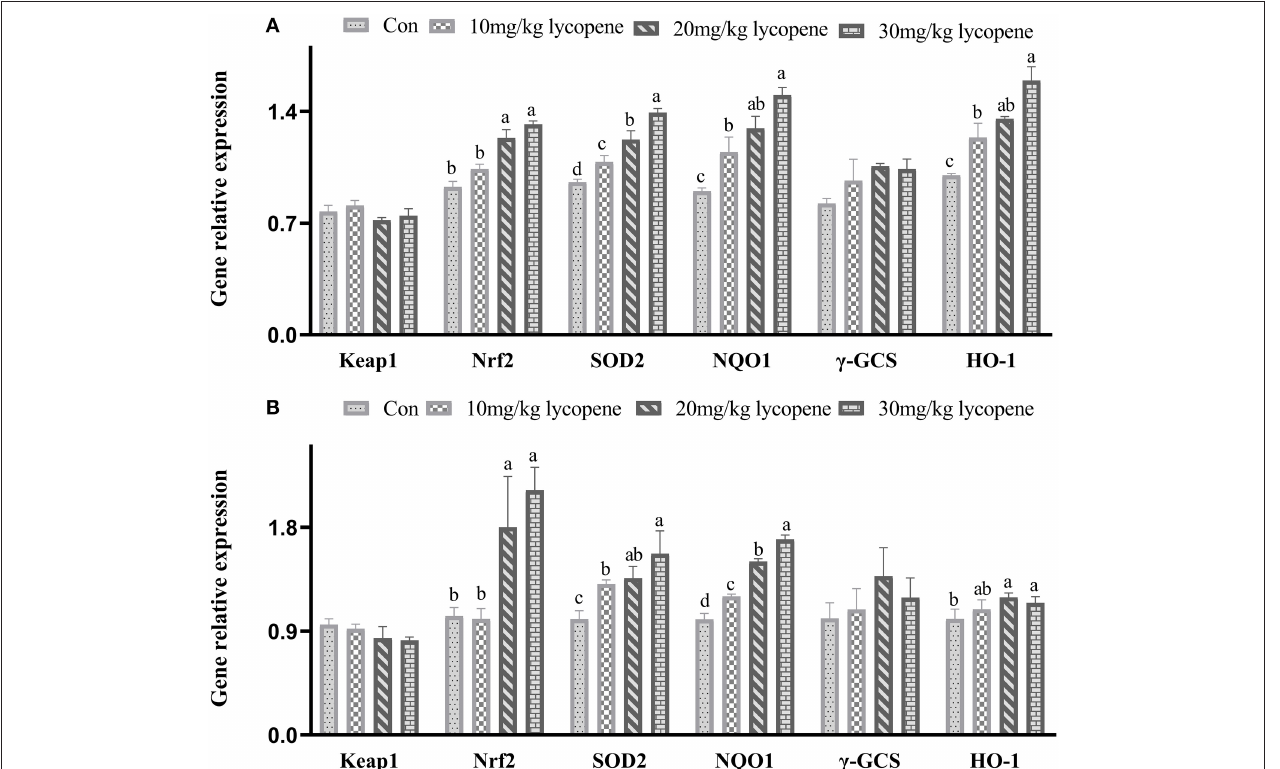
FIGURE 1 | Effect of dietary lycopene levels on the Keap1-Nrf2 regulated gene expression in the liver of AA broilers. (A) The data of Keap1-Nrf2 regulated gene expression in the liver of AA broilers at 21 days in Con, 10, 20, and 30 mg/kg lycopene groups were as follows: Keap 1 gene: 0.77 ± 0.04, 0.81 ± 0.03, 0.72 ± 0.02, and 0.75 ± 0.04, respectively, p = 0.064; Nrf2 gene: 0.93 ± 0.03 b , 1.04 ± 0.03 b , 1.23 ± 0.05 a , and 1.32 ± 0.02 a , respectively, p = 0.042; SOD2 gene: 0.96 ± 0.02 d , 1.08 ± 0.04 c , 1.22 ± 0.05 b , and 1.39 ± 0.02 a , respectively, p = 0.021; NQO1 gene: 0.90 ± 0.02 c , 1.15 ± 0.09 b , 1.29 ± 0.08 ab , and 1.50 ± 0.04 a , respectively, p = 0.035; γ -CGS gene: 0.82 ± 0.03, 0.97 ± 0.13, 1.06 ± 0.02, and 1.35 ± 0.5, respectively, p = 0.072; HO-1 gene: 1.00 ± 0.01 c , 1.24 ± 0.09 b , 1.35 ± 0.01 ab , and 1.59 ± 0.09 a , respectively, p = 0.043. (B) The data of Keap1-Nrf2 regulated gene expression in the liver of AA broilers at 42 days in Con, 10, 20, and 30 mg/kg lycopene groups were as follows: Keap 1 gene: 0.96 ± 0.05, 0.92 ± 0.04, 0.84 ± 0.10, and 0.82 ± 0.03, respectively, p = 0.074; Nrf2 gene: 1.03 ± 0.07 b , 1.00 ± 0.09 b , 1.80 ± 0.44 a , and 2.12 ± 0.20 a , respectively, p = 0.038; SOD2 gene: 1.00 ± 0.07 c , 1.31 ± 0.04 b , 1.36 ± 0.10 ab , and 1.57 ± 0.20 b , respectively, p = 0.025; NQO1 gene: 1.00 ± 0.05 d , 1.20 ± 0.02 c , 1.50 ± 0.02 b , and 1.70 ± 0.04 a , respectively, p = 0.034; γ -CGS gene: 1.00 ± 0.14, 1.09 ± 0.18, 1.37 ± 0.25, and 1.19 ± 0.17, respectively, p = 0.059; HO-1 gene: 1.00 ± 0.08 b , 1.09 ± 0.08 ab , 1.19 ± 0.04 a , and 1.15 ± 0.05 a , respectively, p =